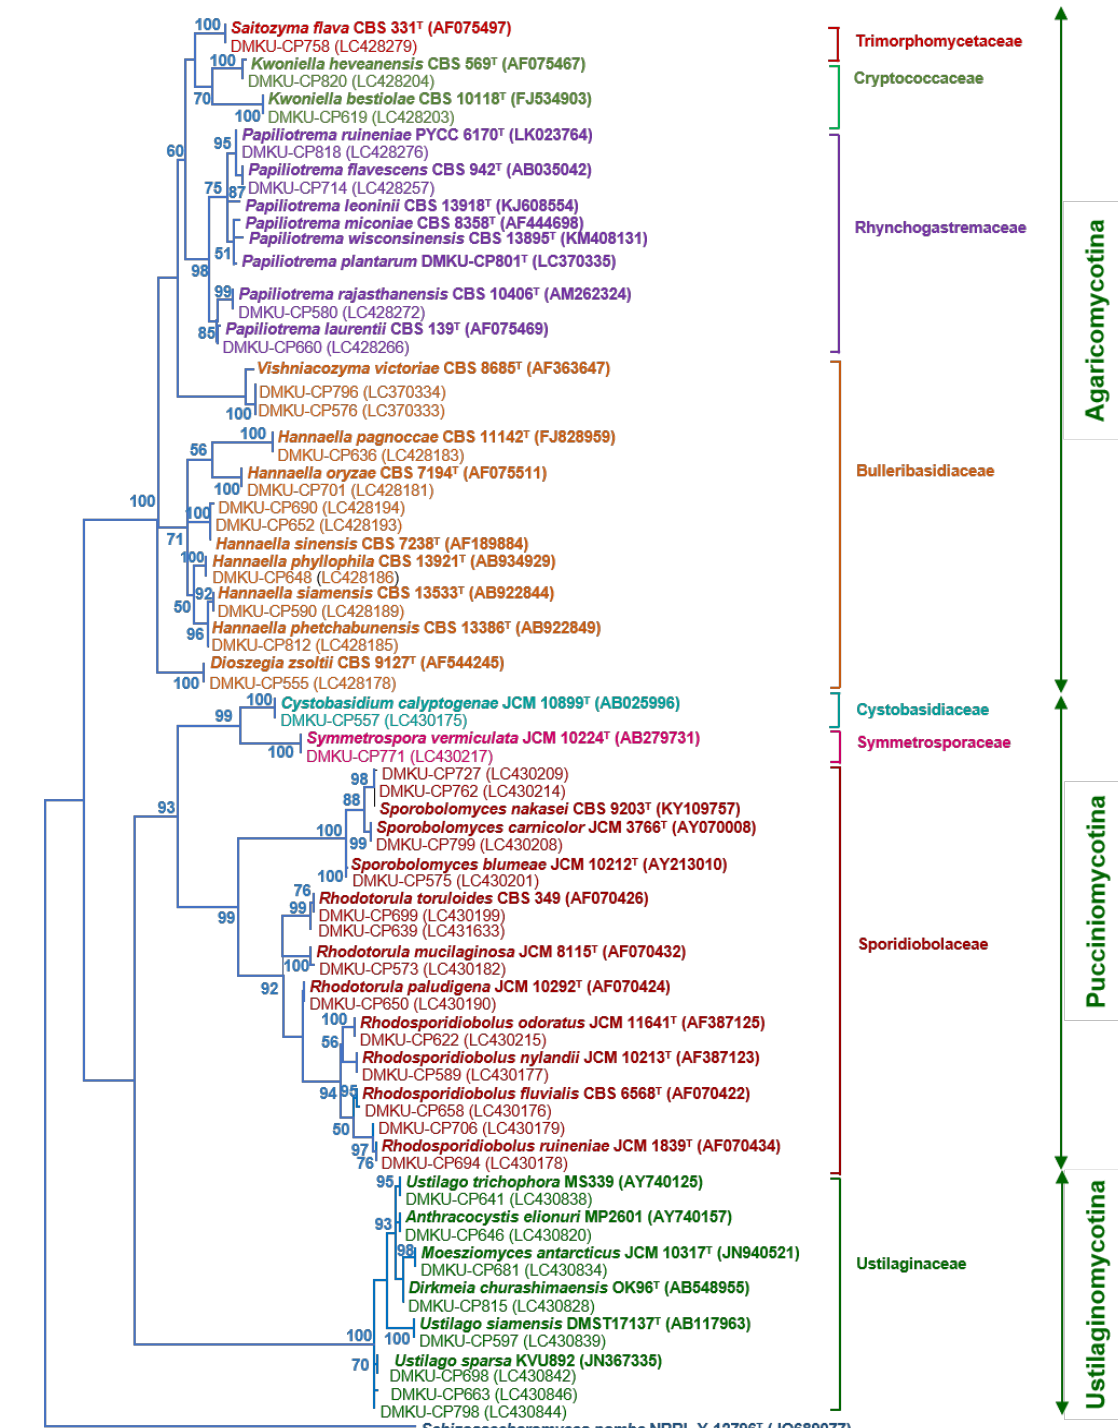
Figure 3. Phylogenetic placement of known species of corn phylloplane basidiomycetous yeasts (Phylum Basidiomycota: subphylum Pucciniomycotina, Ustilaginomycotina and Agaricomycotina) based on the sequence of the D1 / D2 region of LSU rRNA gene. Reference sequences retrieved from the GenBank database are included. The tree was constructed with the maximum-likelihood method and the GTR evolutionary model. Numbers on branches represent the bootstrap values ( > 50%) from 1000 random replicates. The scale bar corresponds to a genetic distance of 0.05 substitutions per position.